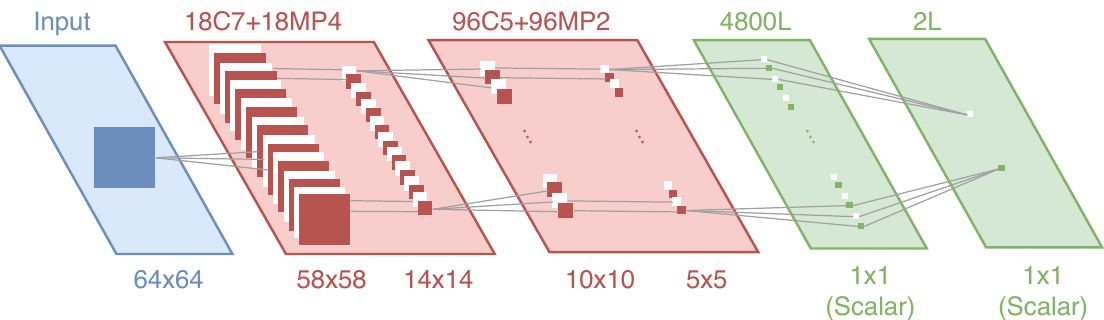
Figure 5. Architecture of the Convolutional Neural